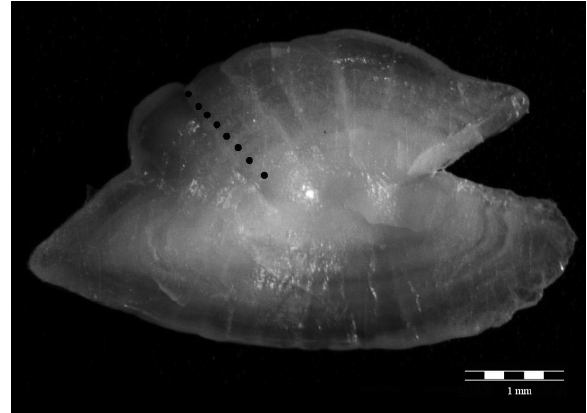
Fig . 6. – Sagittal otolith of the 8-year-old male Labrus mixtus , with 30.0 cm TL (Adriatic